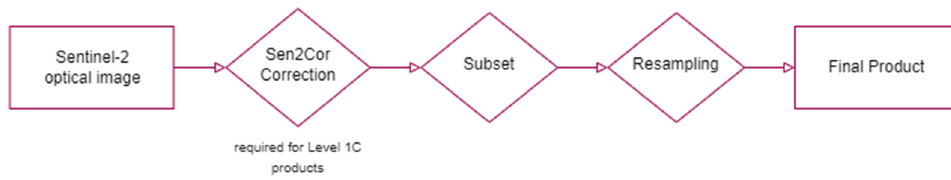
Figure 5. Pre-processing workflow of optical